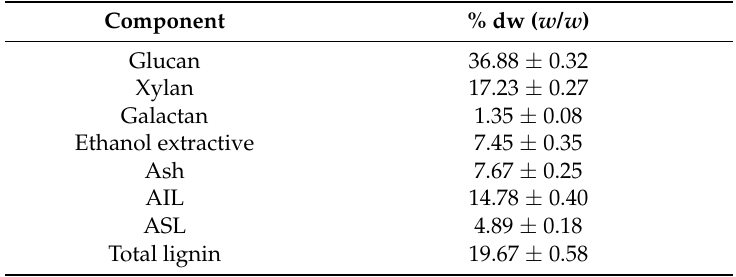
Table 1. Chemical composition of Chloris barbata .